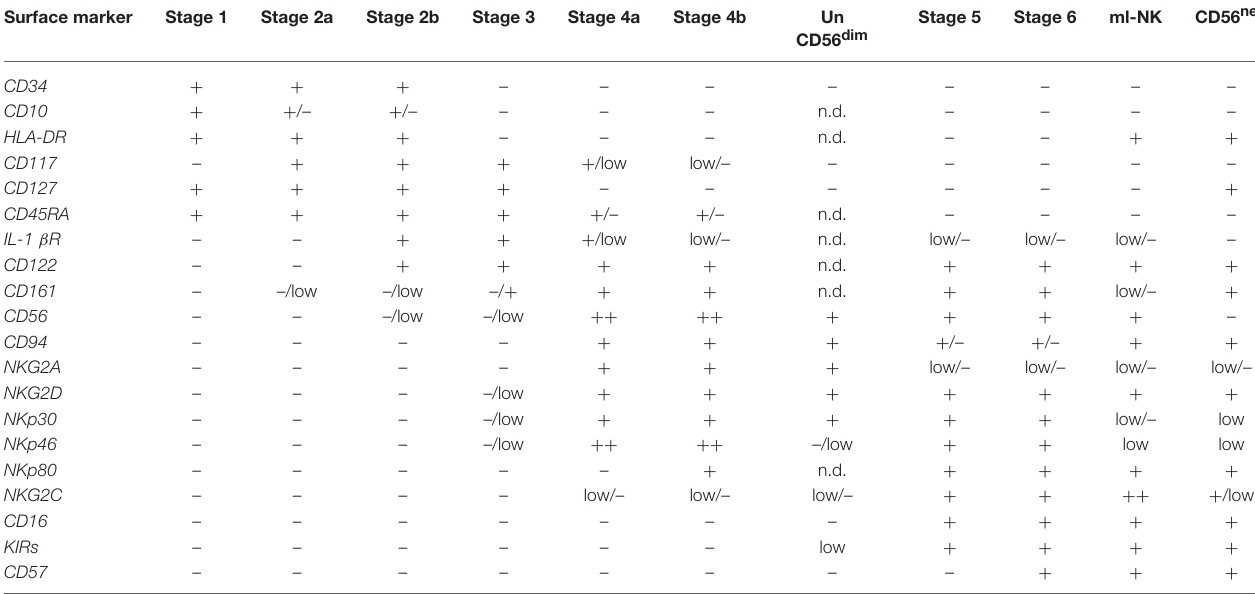
TABLE 1 | Principal surface markers differentially expressed on NK cell developmental intermediates. Surface